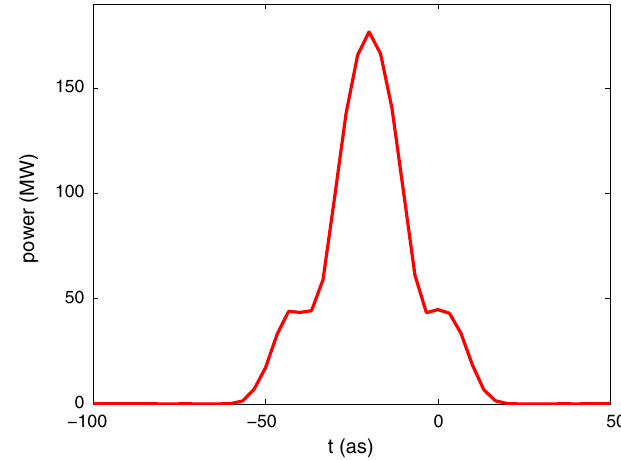
FIG. 7. (Color) Power of the generated 1 nm x-ray pulse. The pulse length is 20 as